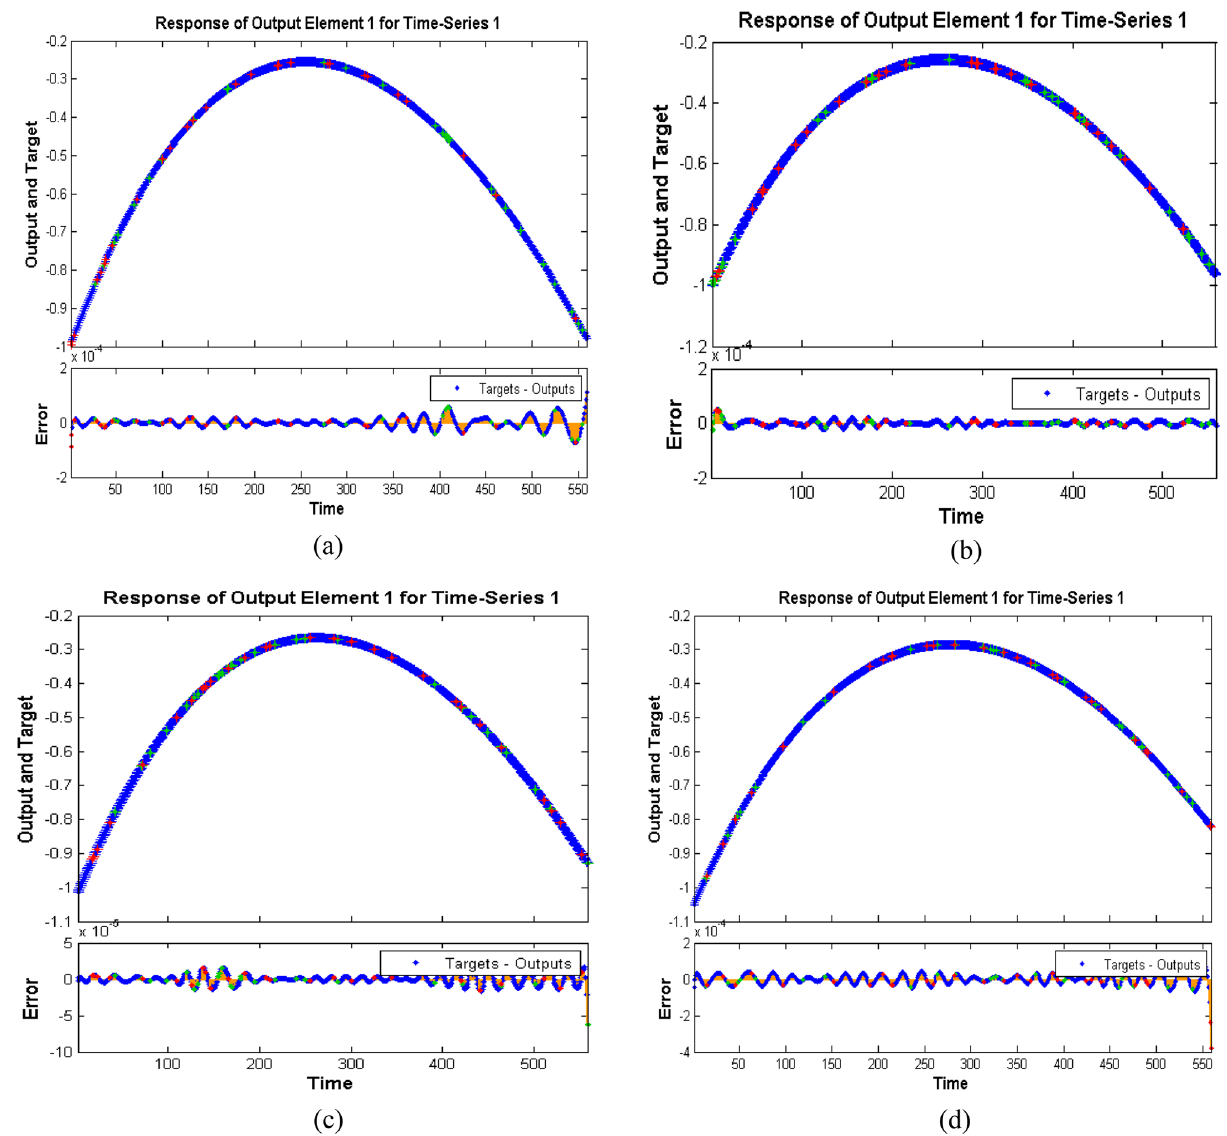
Figure 13. Time series response of case study 1: scenario 1 ( a ) case 1, ( b ) case 2, ( c ) case 3 and ( d ) case